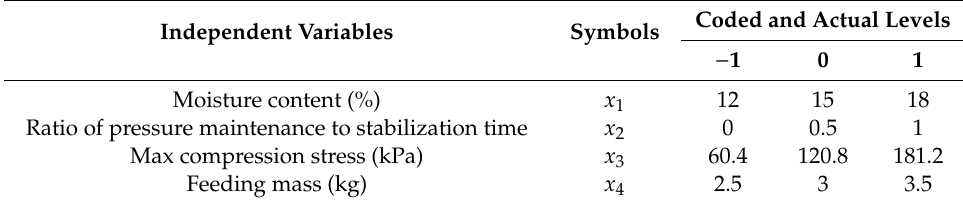
Table 1. Actual and coded levels of compression process